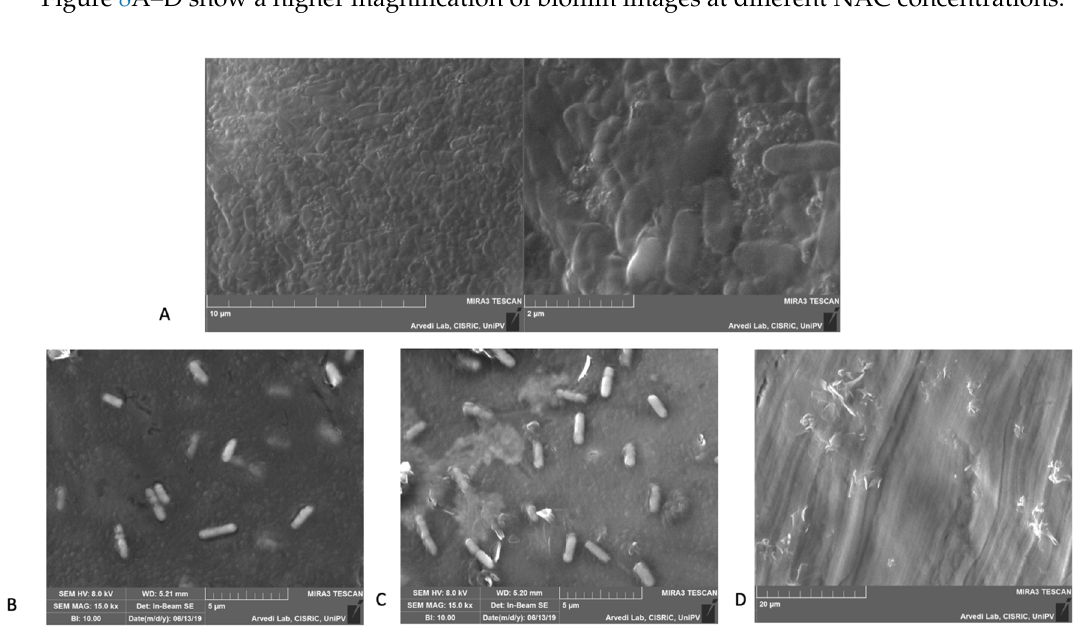
Figure 8. Higher magnification of SEM pictures of a Pseudomonas aeruginosa Biofilm on an untreated steel-surface of: ( a ) untreated biofilm; ( b ) biofilm with 0.5 mg·mL − 1 of NAC; ( c ) biofilm with 2 mg·mL − 1 of NAC; ( d ) biofilm with 4 mg·mL − 1 of NAC.